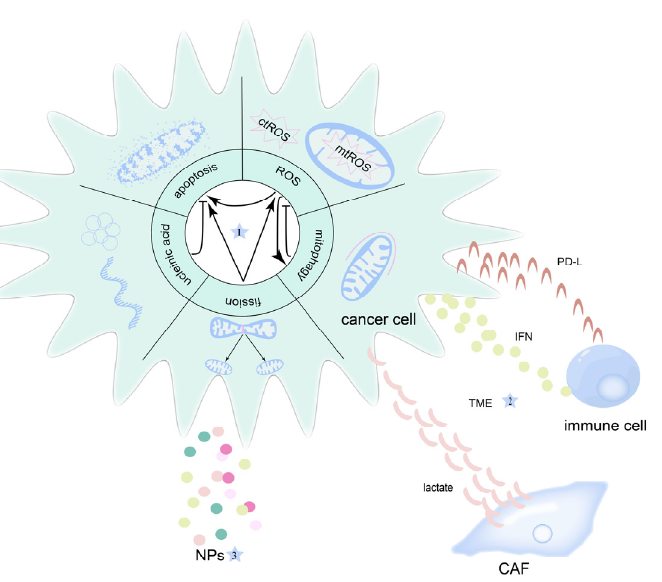
Figure 1. Overview of the role of mitochondria in the therapy and therapeutic resistance of oral squamous cell carcinoma (OSCC). (1) Mitochondrial function and their connection in OSCC. (2) In- teraction between mitochondria and the tumor microenvironment (TME) constituents including immune cells and CAF (cancer-associated fibroblast). (3) Nanoparticles (NPs) were used to treat OSCC by targeting mitochondria.